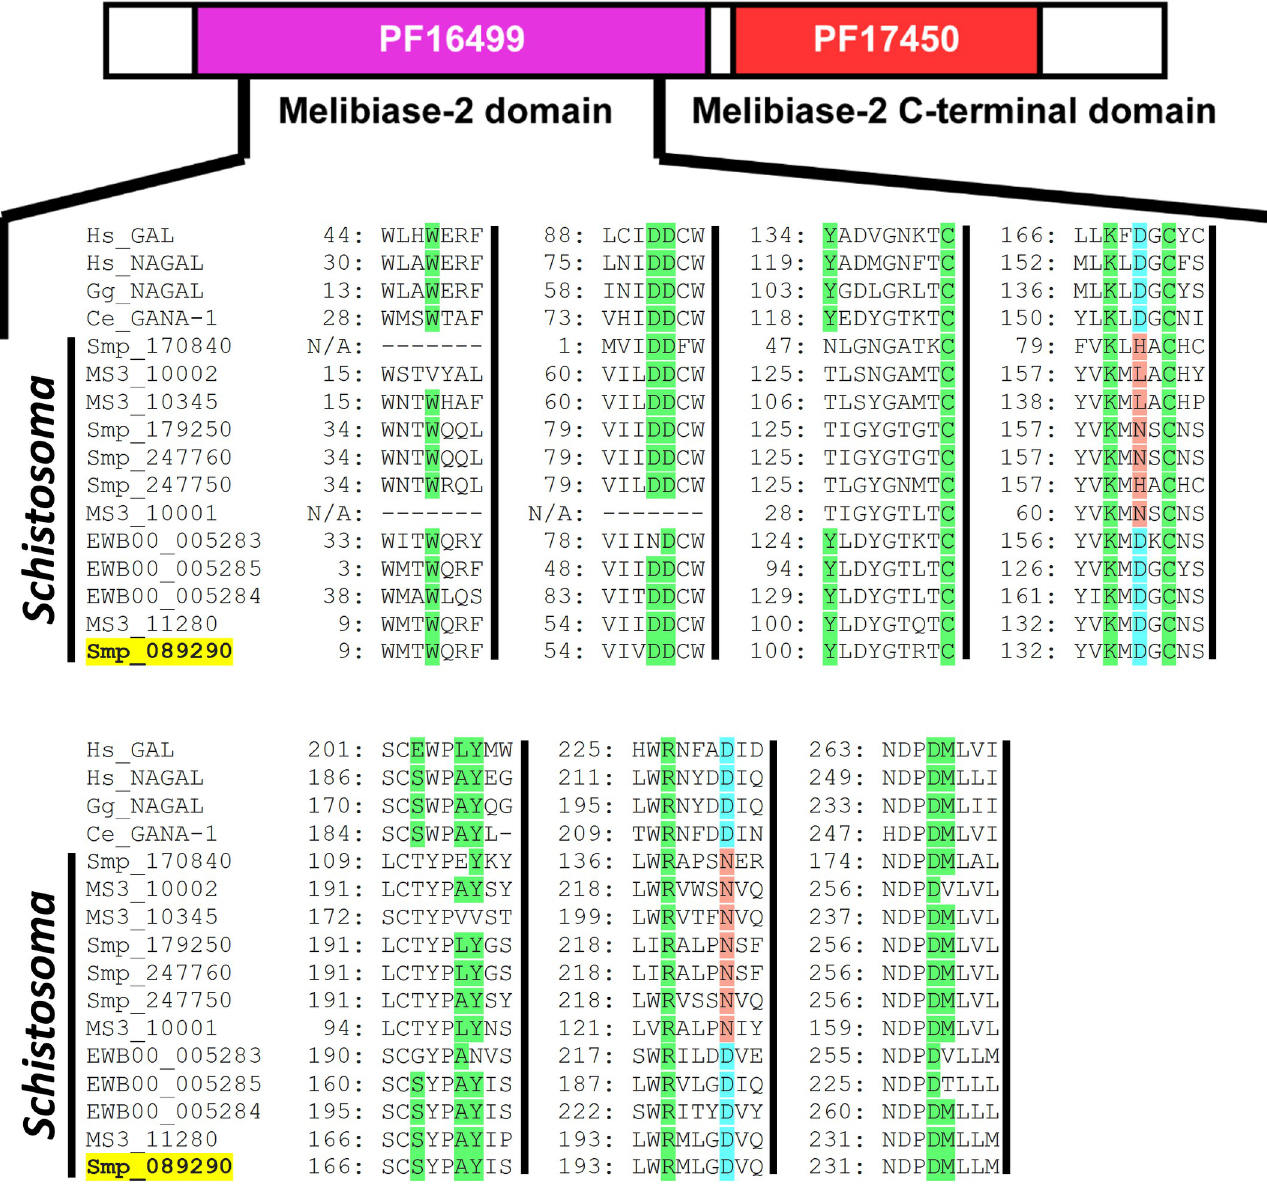
Fig 1. Schistosoma mansoni contains five GH27 family members, but only Smp_089290 contains all residues necessary for α -NAGAL substrate binding and cleavage. A concatenated multiple sequence alignment of α -GAL and α -NAGAL proteins from H . sapiens (Hs), G . gallus (Gg), C . elegans (Ce), S . japonicum (EWB), S . mansoni (Smp), and S . haematobium (MS3) throughout the melibiase-2 domain (PF16499). Numbers located at the beginning of each sequence represent the amino acid position in the protein sequence. Ligand binding residues are highlighted green whereas non-conserved amino acids in the same position in other sequences are white. Catalytic aspartic acid (D) residues are highlighted light blue whilst non-conserved amino acids in the same position in other sequences are highlighted red. Amino acid residues which are missing from ‘Ce_GANA-1’, ‘Smp_170840’ and ‘MS3_10001’ are indicated with — whereas N/A is used for the amino acid